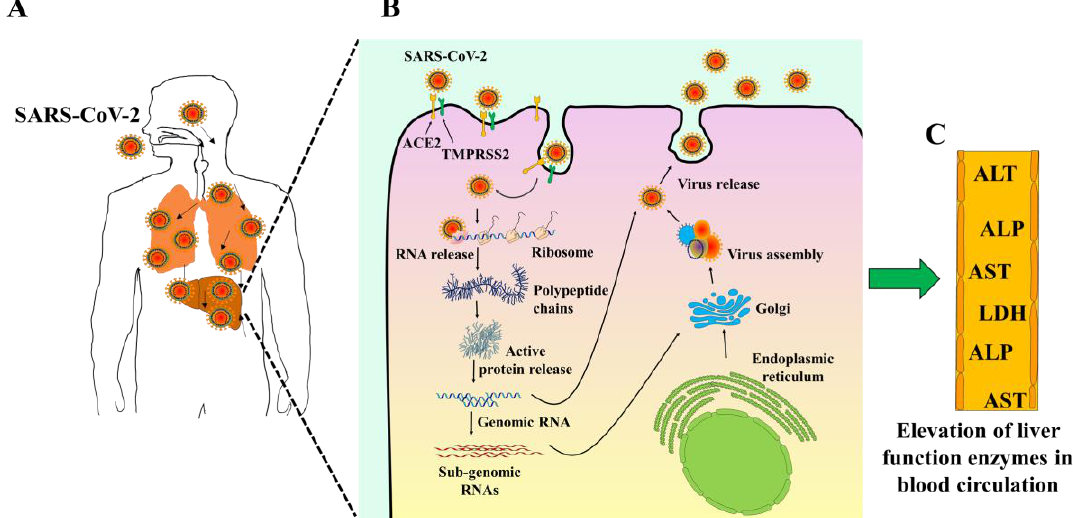
Figure 2. Schematic diagram showing the potential mechanisms of liver injury and abnormality in liver. ( A ); COVID-19 infection through the respiratory tract. ( B ); SARS-CoV-2 binds via its